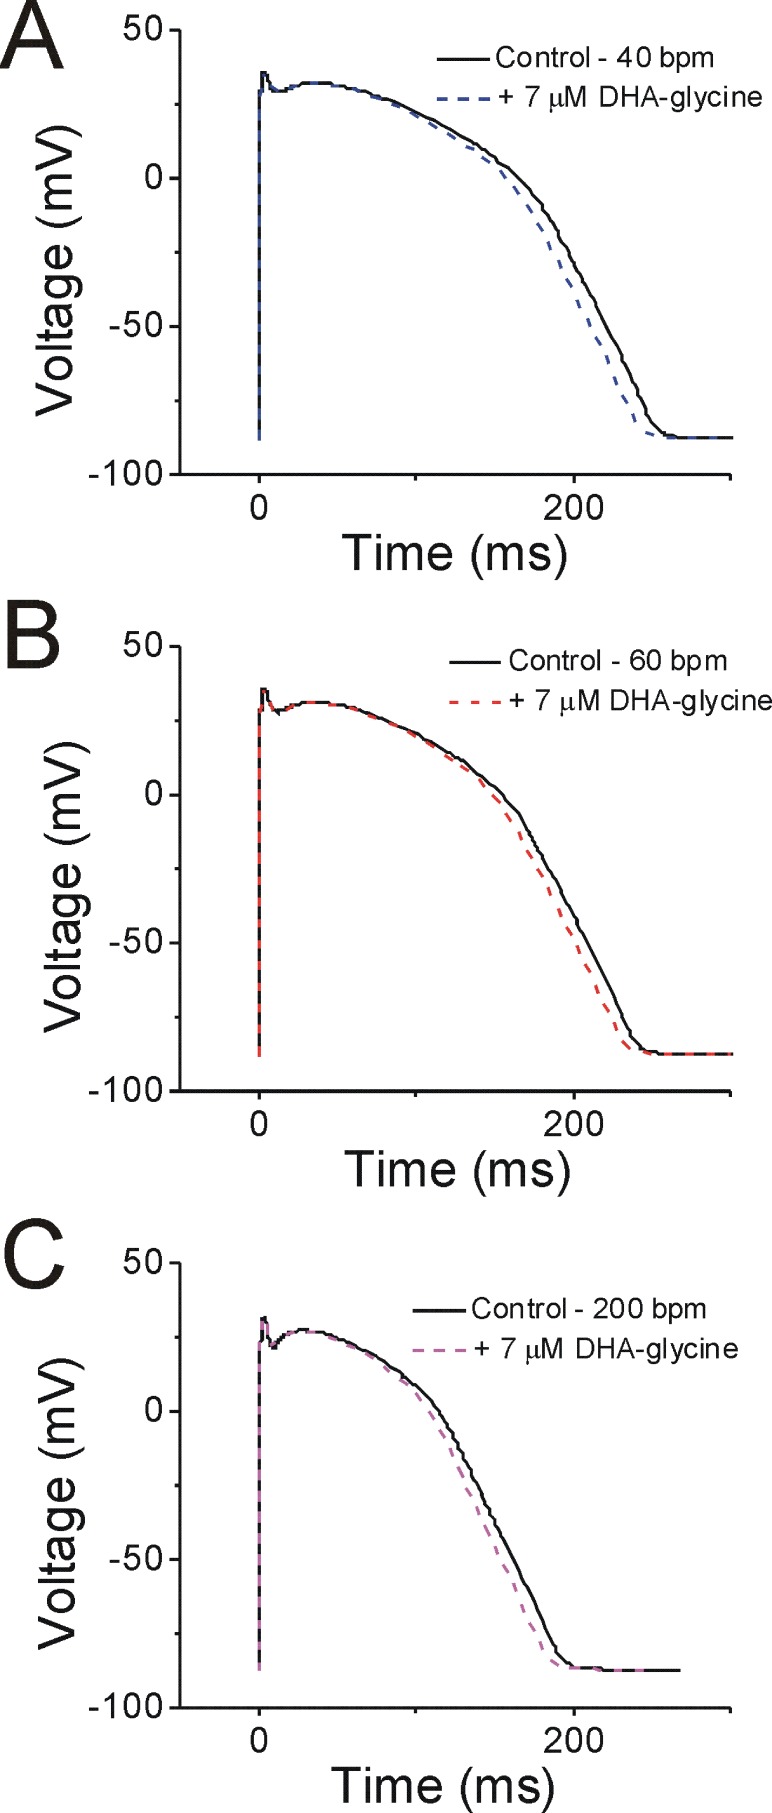
Rate dependence of the simulated ventricular action potential and effects of DHA-glycine.(A) Simulations of the ventricular action potential at 40 bpm in control conditions (black) and simulated effects of 7 µM DHA-glycine (blue dashed line). (B) Simulations of the ventricular action potential at 60 bpm in control conditions (black) and simulated effects of 7 µM DHA-glycine (red dashed line). (C) Simulations of the ventricular action potential at 200 bpm in control conditions (black) and simulated effects of 7 µM DHA-glycine (magenta dashed line).